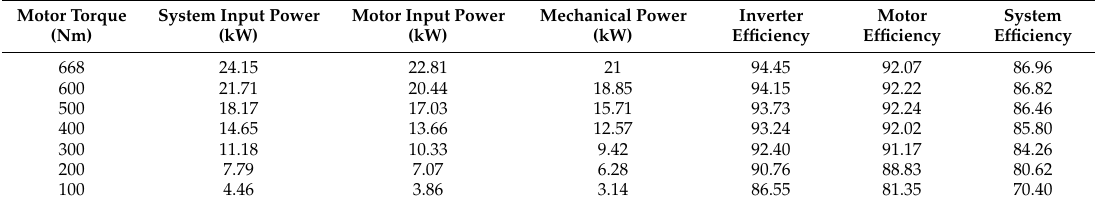
Table 6. Experimental results in the rated speed by the system efficiency improvement